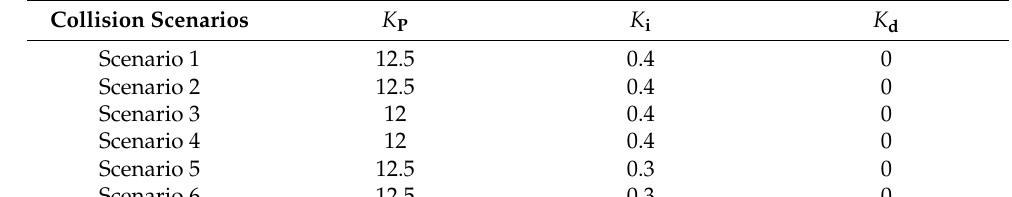
Table 5. Specific lower controller parameters.